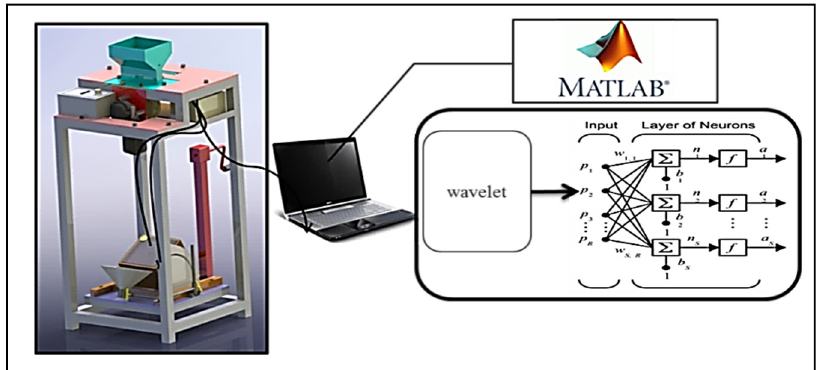
Figure 14. The relationship between the different parts of system, software and hardware.